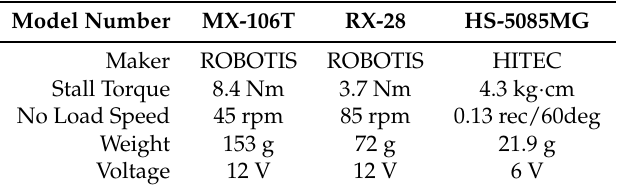
Figure 9. Designable range satisfying Equation (4). “ × ” highlighted in red represents the actual design parameter, and it satisfies Equation (4). Thus, RX-28 is able to generate enough driving torque as a base actuator. Table 1. Specifications of the servo motors.